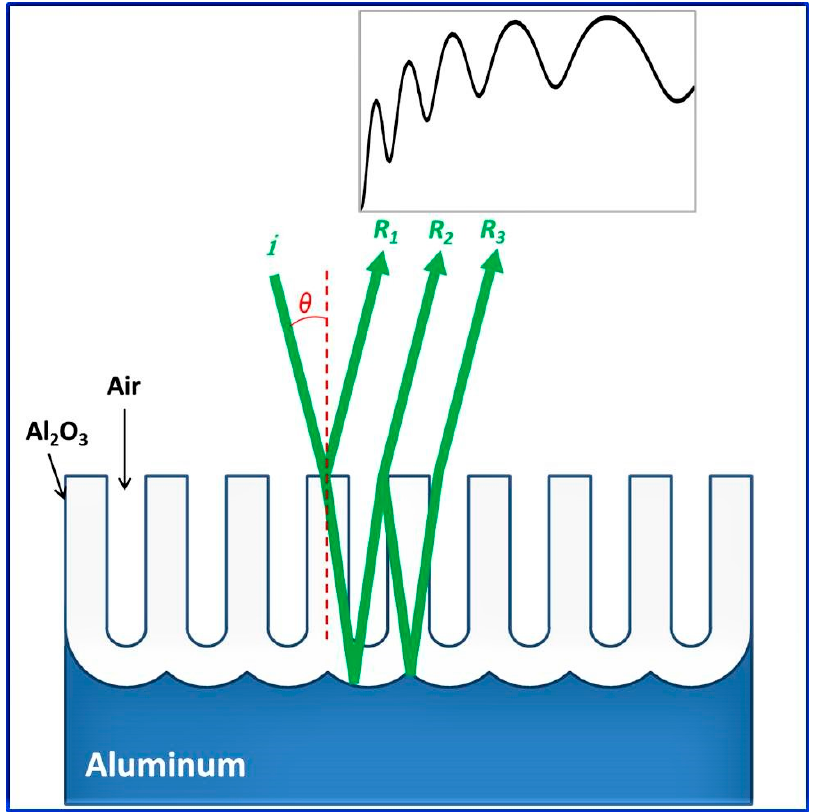
Figure 9. A schematic showing the origin of oscillations arising from the interaction of light with NAA; R 1 , R 2 , and R 3 are the reflected waves leading to interference, θ is the angle of incidence,